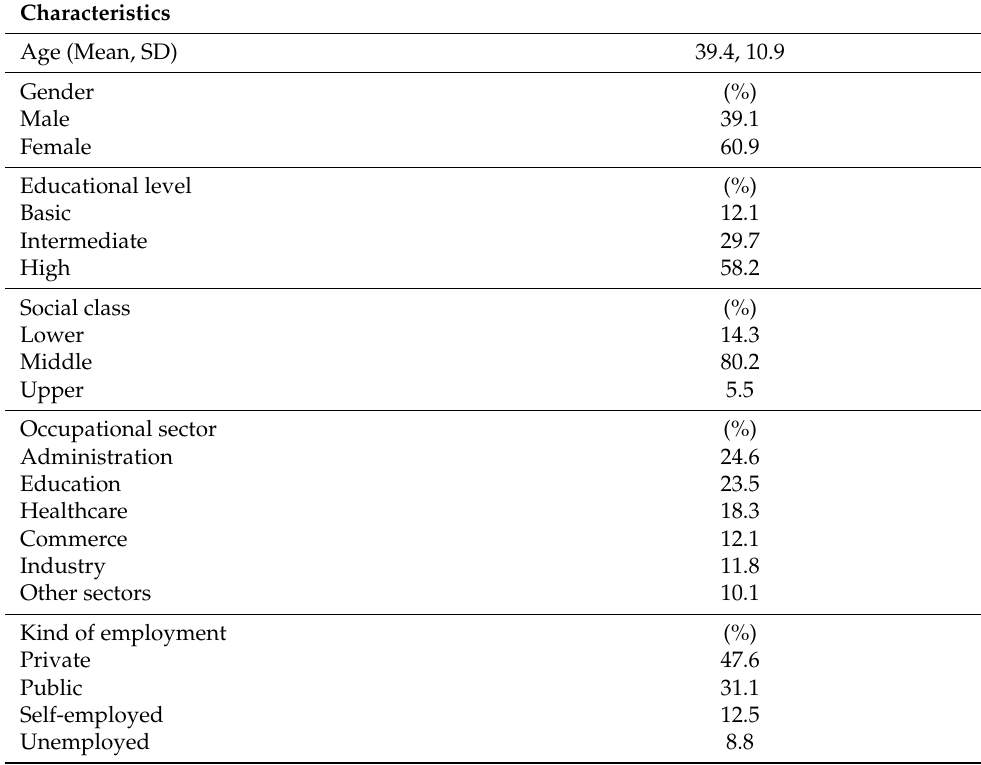
Table 1. Individual characteristics of the